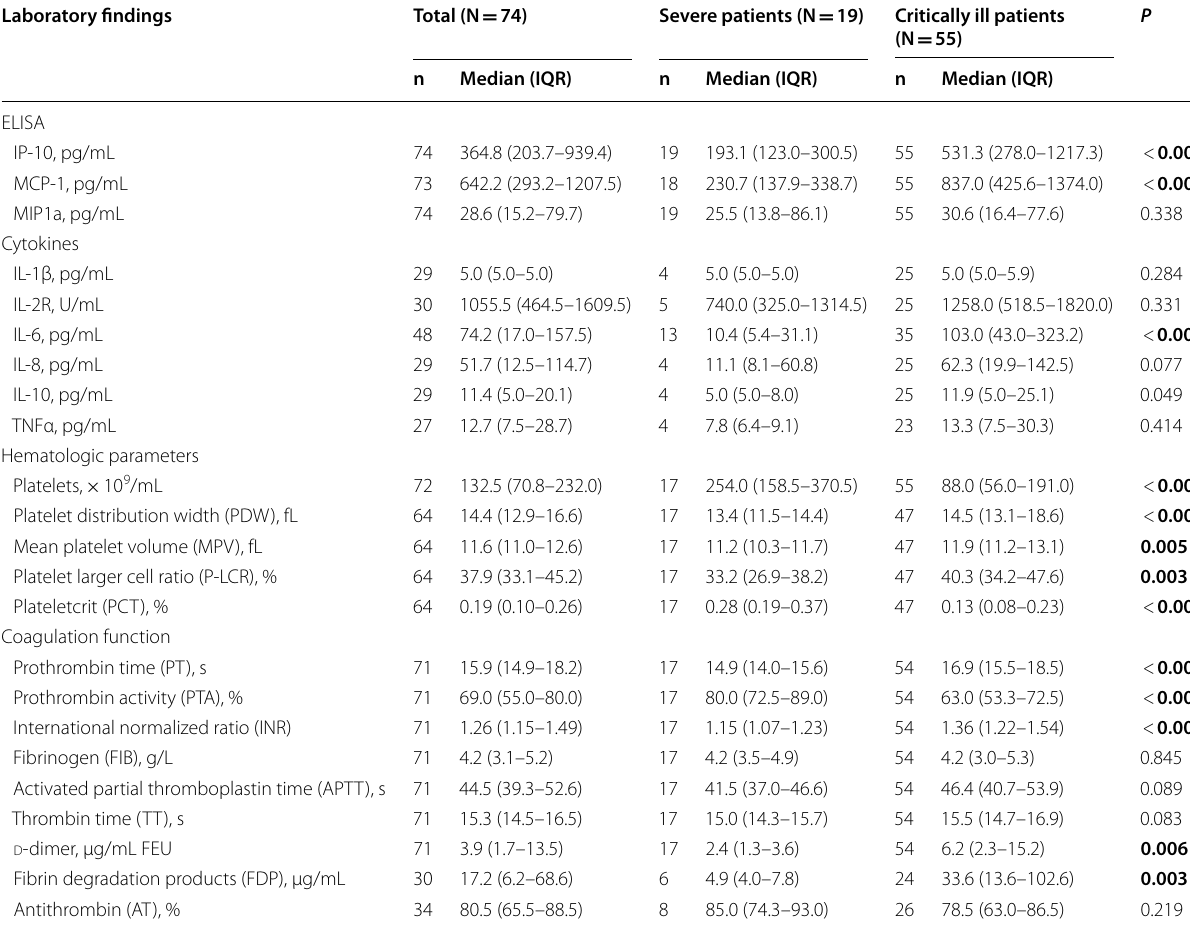
Bold indicates the statistically significant values ( P <